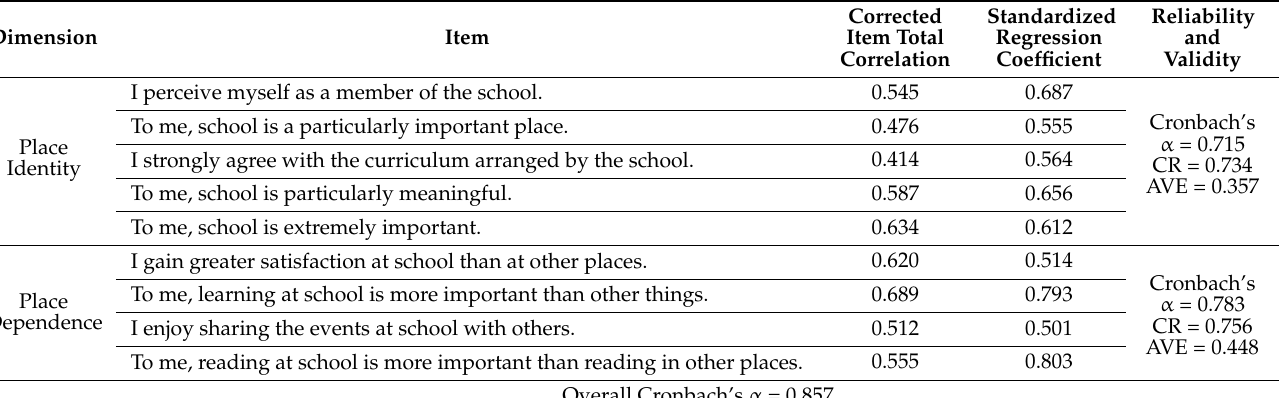
Table 1. Summary of the results of the reliability and validity analysis of the Environment Attachment